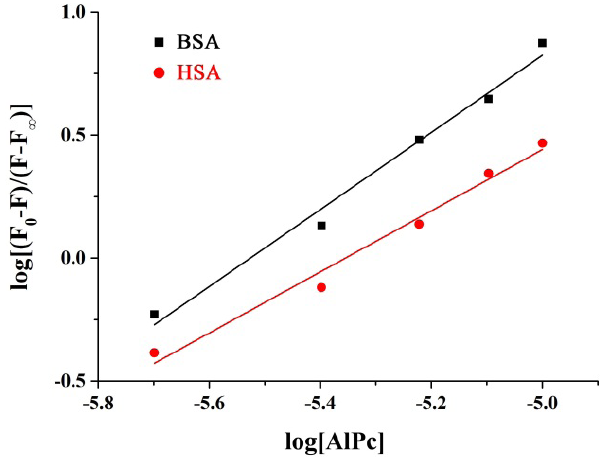
Fig. 4. Double logarithmic plots of °uorescence changes of serum albumins against di®erent concentrations of AlPc com- plex. BSA: black ¯lled square; HSA: red ¯lled circle.